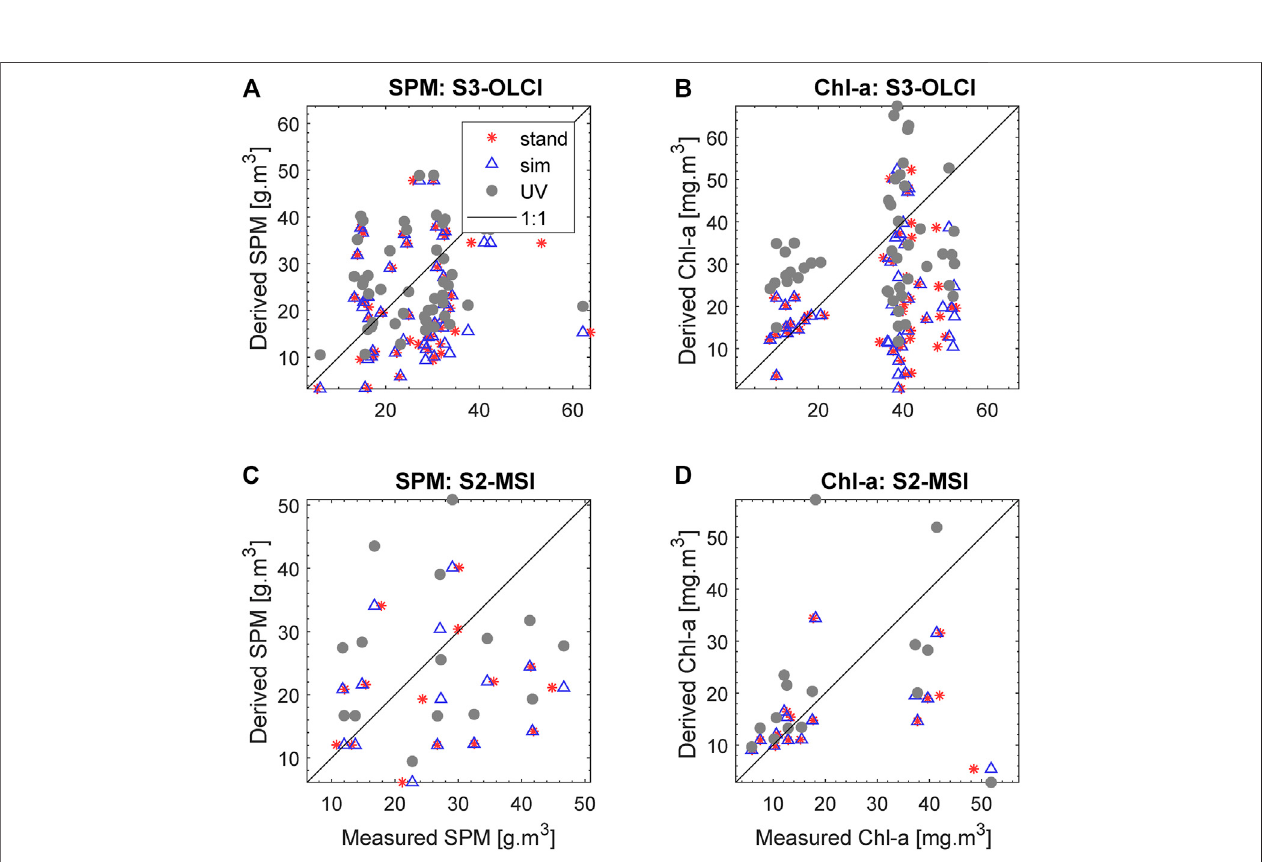
FIGURE 6 | The results of the standard approach (Stand, red stars), after selecting similar measurements (Sim, blue triangles) and unbiased validation (UV, gray circles) applied to similar measurements for SPM (A,C) and Chl-a (B,D) derived from S3-OLCI (A,B) and S2-MSI (C,D) .